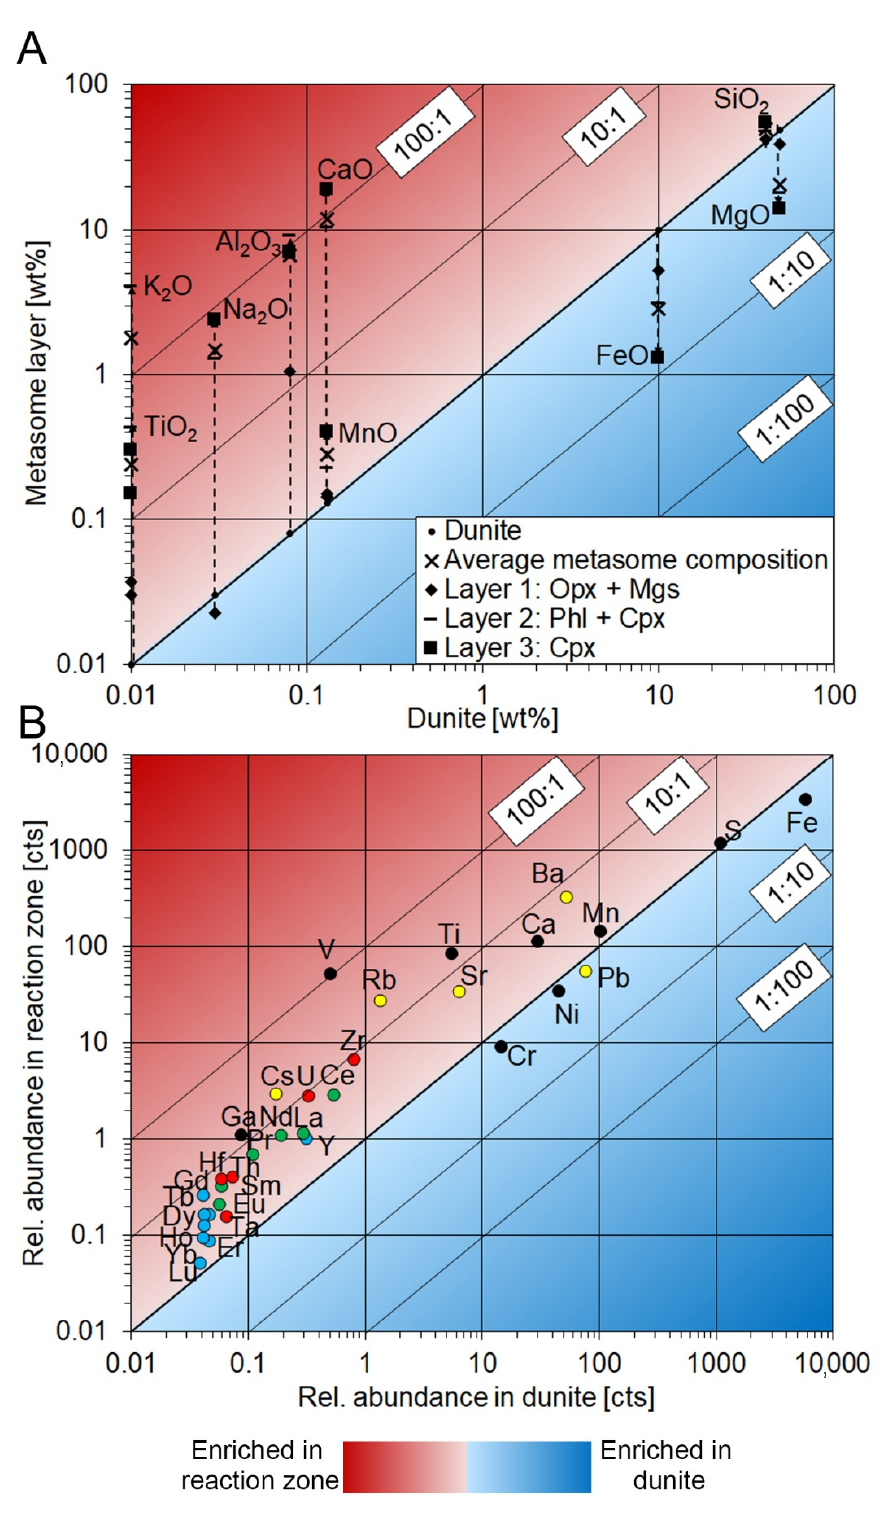
Figure A4. Isocon plots of the metasomatized layers versus the unaltered dunite composition. ( A ) Major oxide composition of the metasomatic layers as determined by EPMA. K 2 O, CaO, and Al 2 O 3 are most strongly enriched and plot above the 100:1 enrichment band. This enrichment is balanced by progressive decrease in FeO and MgO from layer 1 to 3. ( B ) Relative enrichment (cts—signal counts) of the average reaction zone as determined by LA-ICP-TOFMS (black circles—major and minor elements, yellow circles—LILEs, red circles—HFSEs, green circles—LREEs, and blue circles—HREEs + Y).